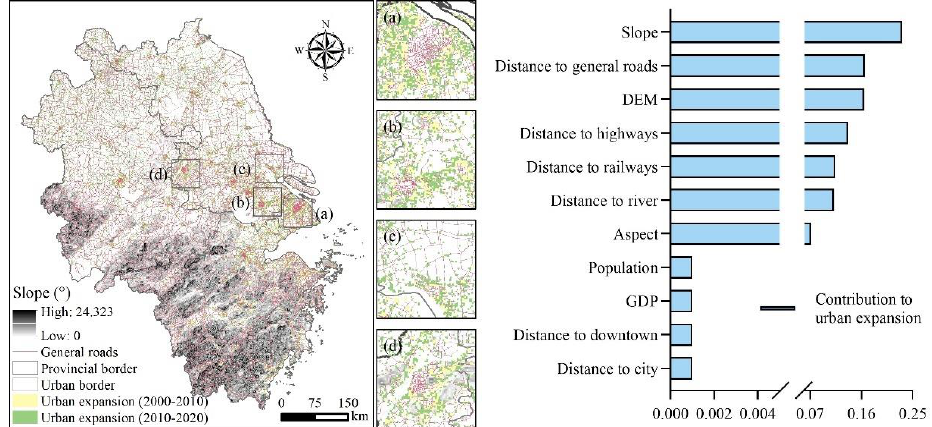
Figure 5. Contribution of drivers such as slope and general roads to urban expansion: ( a ) Shanghai, ( b ) Suzhou, ( c ) Nantong, ( d ) Nanjing. Cropland occupation was the main cause of TCS loss in the YRD region (Table 5).